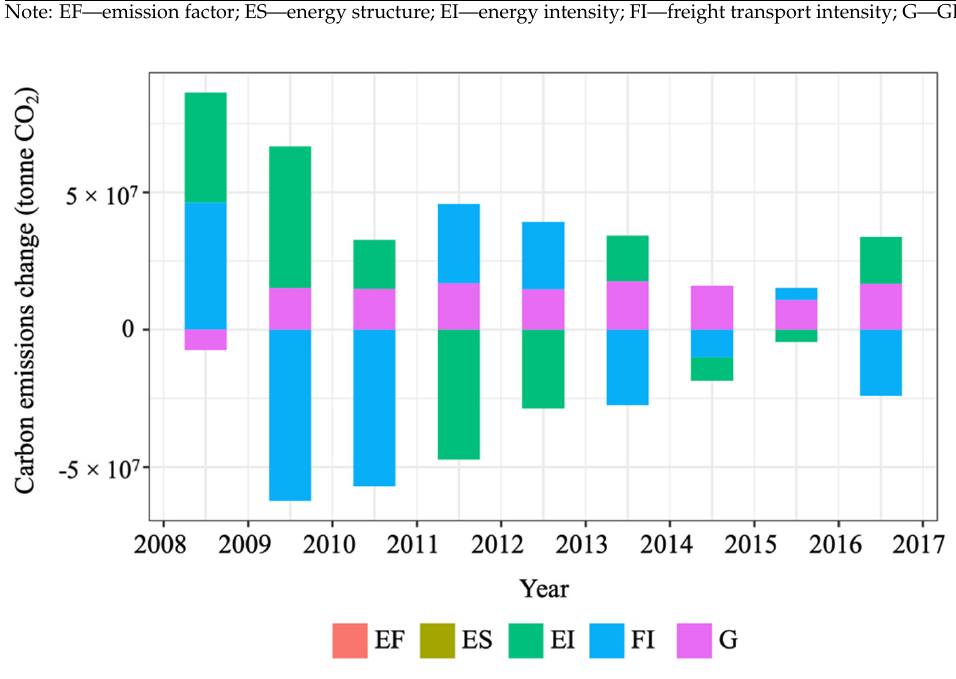
Figure 6. Decomposition results for the U.S. CO 2 emissions in road freight transport.